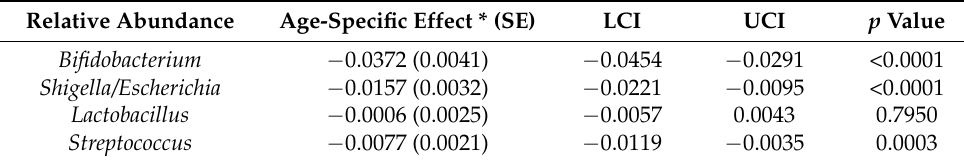
Figure 5. Effect of increasing age on the relative abundance of the most abundant genera: The relative abundance of the four most abundant genera of the gut microbiota of all children, ( a ) Bifidobacterium , ( b ) Escherichia/Shigella ( c ) Lactobacillus , and ( d ) Streptococcus , was assessed in QIIME Version 1.5. The effect of increasing age on the relative abundance of these genera was assessed using a linear mixed-effects model adjusted for gender, residential location, and reported diarrheal episodes. Table 5. Relationship of Age and Relative Abundance of Major